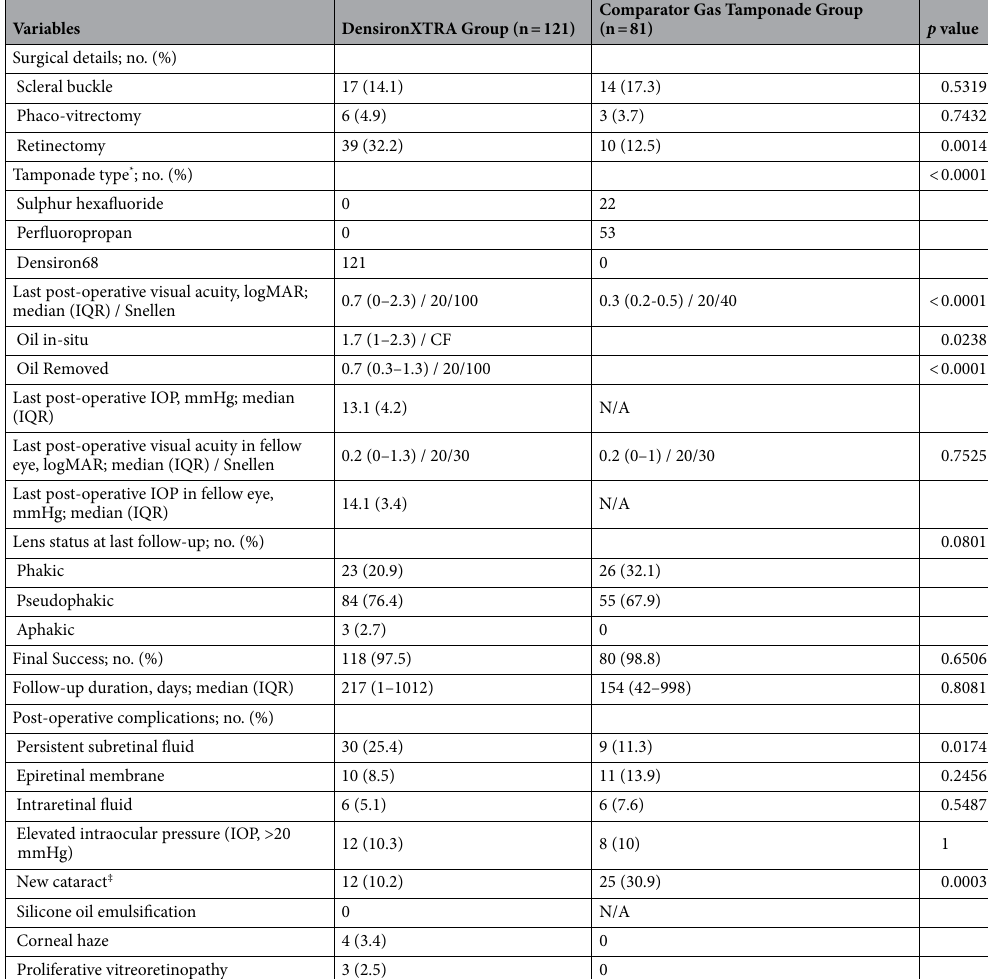
Table 2. Post-operative outcomes of eyes with DensironXTRA and gas tamponade comparator groups included in the analysis. No., number; IQR, interquartile range; SD, standard deviation; LogMAR, logarithm of the minimum angle of resolution; IOP, intraocular pressure; CF, counting fingers. N/A, not available/not applicable. ‡ In cases that were phakic at baseline.